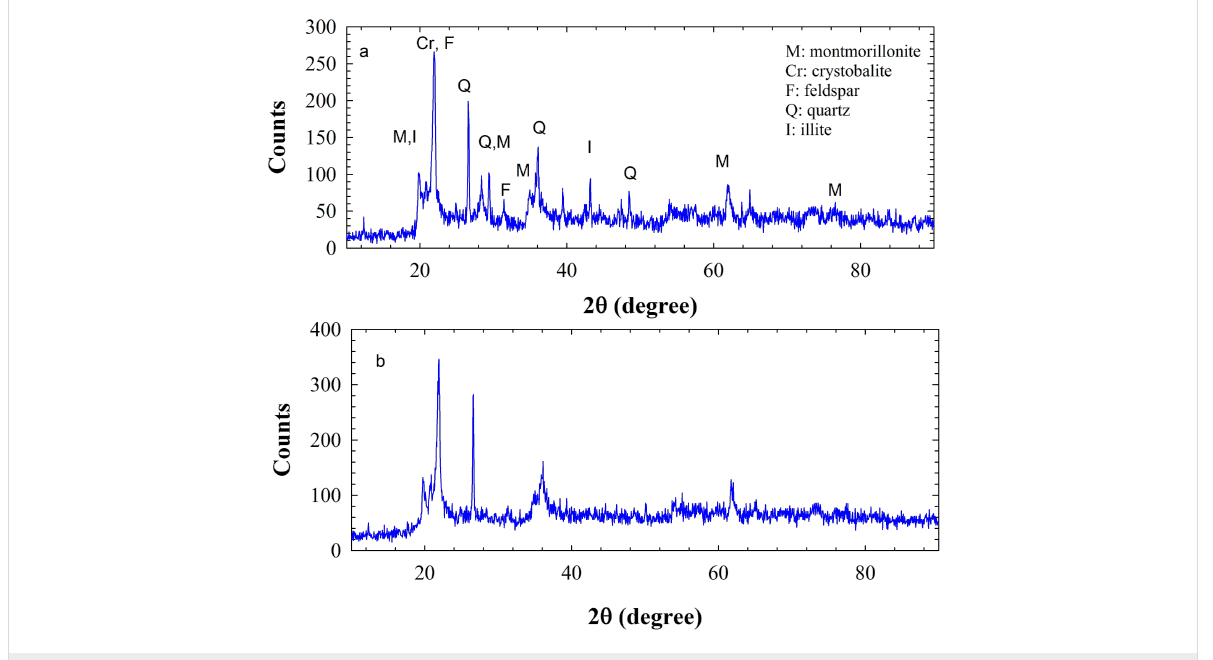
Figure 3: The XRD patterns of natural bentonite (a) and Cu NPs/bentonite (b).